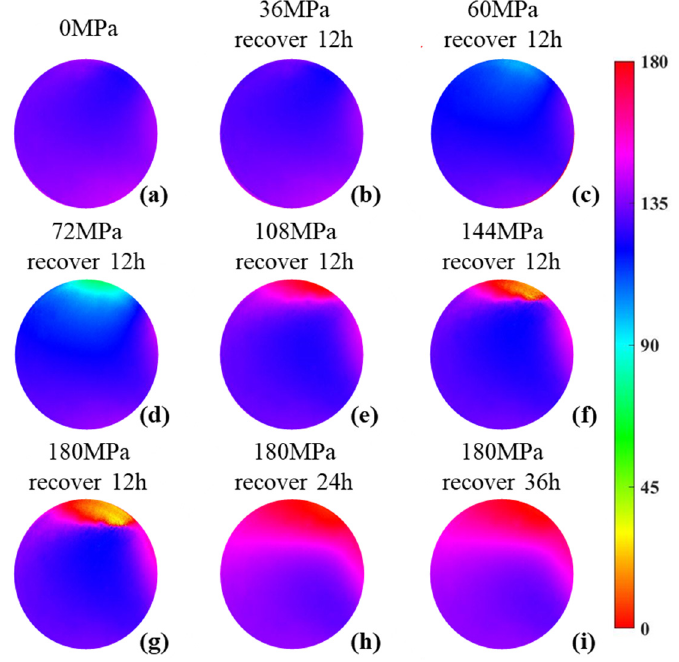
Figure 5. γ images under different pressures and recovery times. ( a – f ): γ images under different pressures; ( g – i ): γ images under different recovery times.